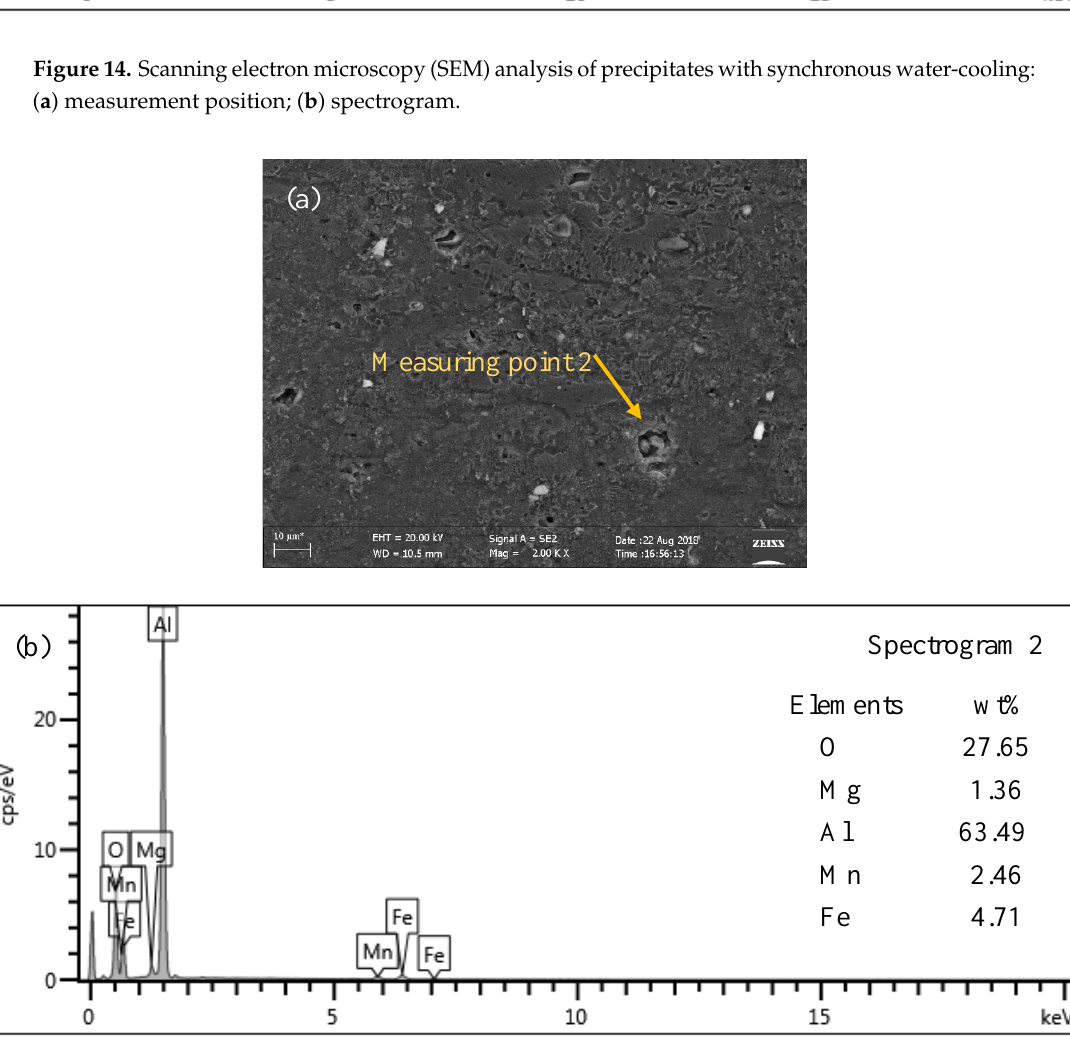
Figure 15. SEM analysis of precipitates with flame straightening: ( a ) measurement position; ( b ) spectrogram.